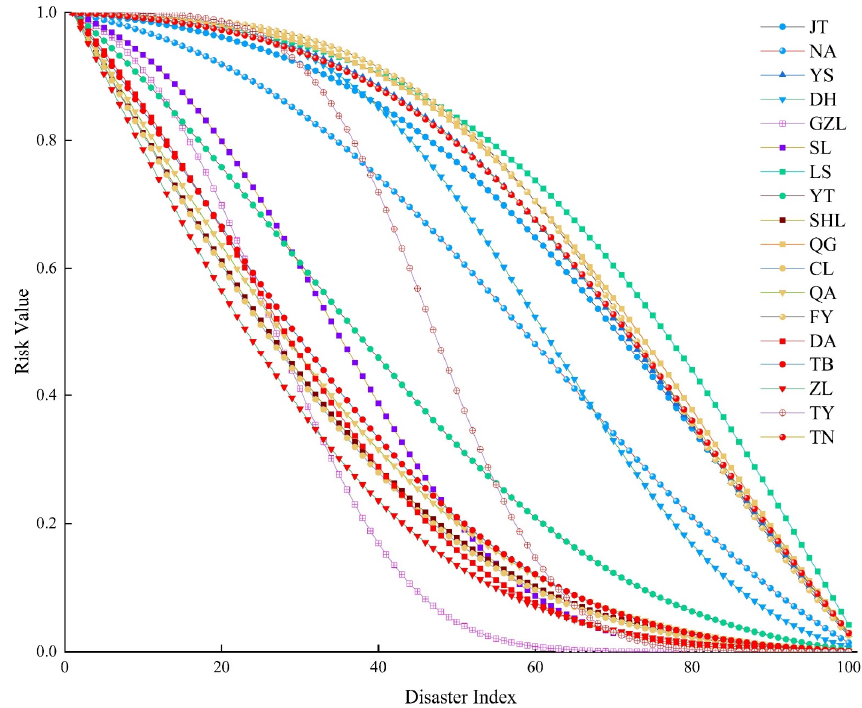
Figure 7. Drought exceedance probability density under different disaster index.